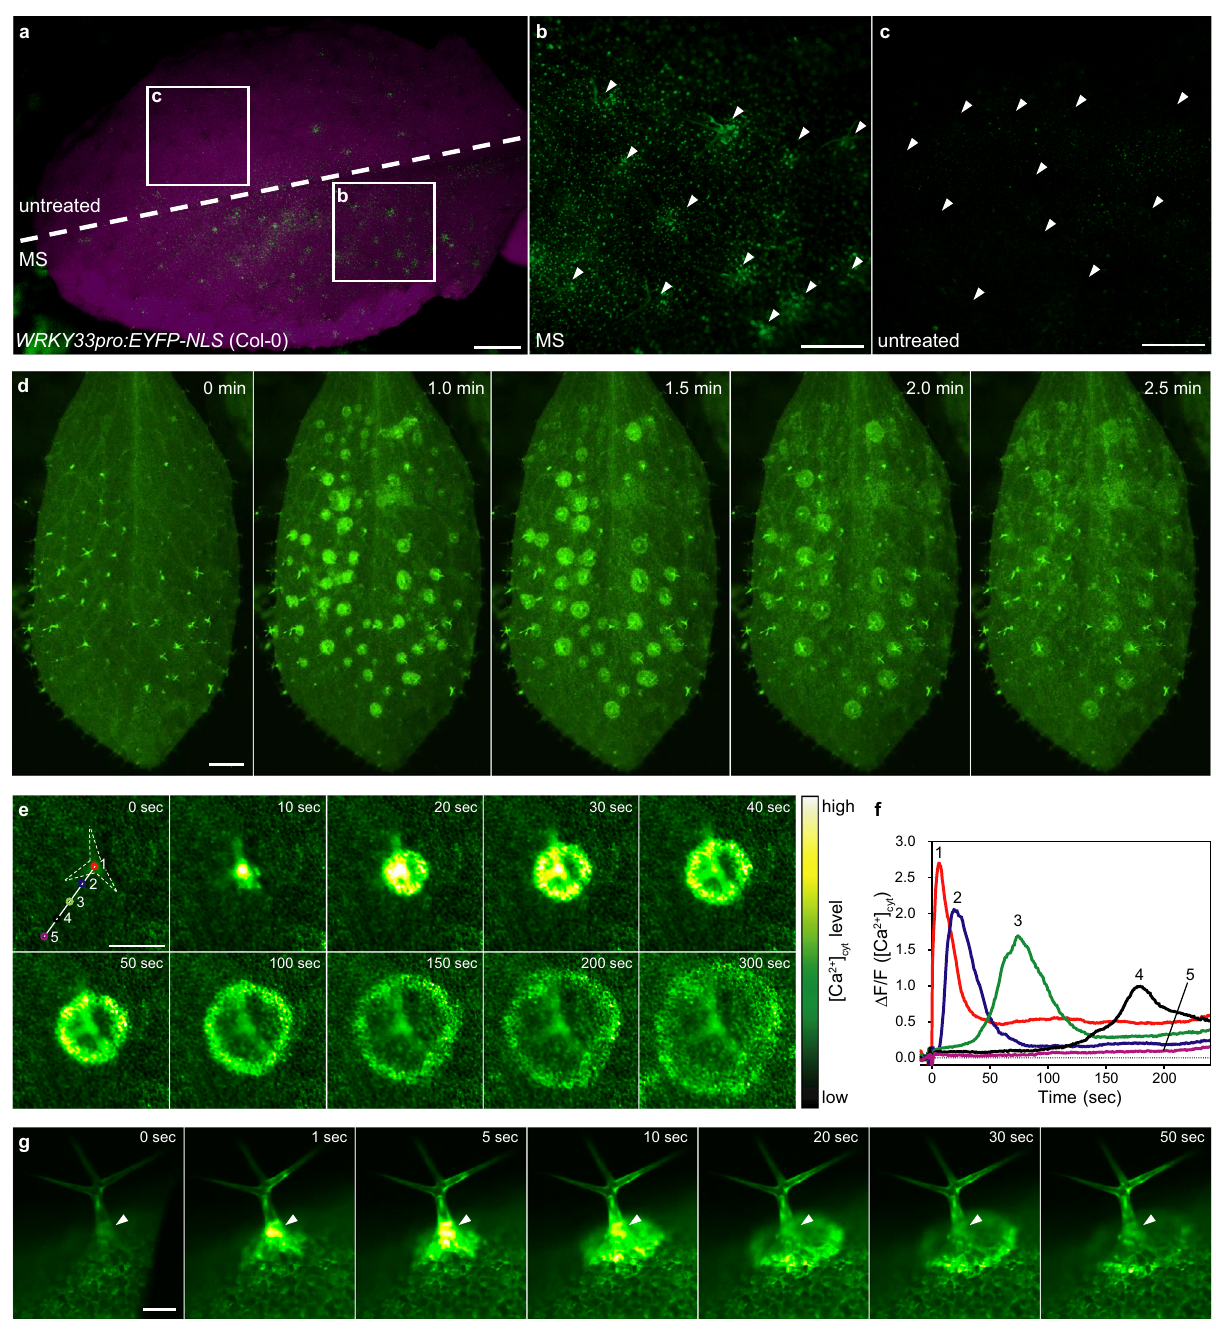
Fig. 4 Trichomes initiate intercellular calcium waves. a – c YFP fl uorescence in a whole leaf from WRKY33pro:EYFP-NLS (Col-0) with (MS, bottom half) or without brushing (untreated, top half) ( a ), along with zoomed-in views of brushed ( b ), and untreated ( c ) areas. Arrowheads indicate trichomes ( b , c ). Scale bars, 0.5 mm ( a ), 0.3 mm ( b , c ). Similar results were obtained in three independent experiments. d Ca 2 + imaging using 35Spro:GCaMP3 (Col-0). The leaf surface of a 4-week-old plant was treated with MS by brushing. MS-induced intercellular calcium waves propagated concentrically from trichomes. Scale bar, 1.0 mm. See also Supplementary Movie 1. e Ca 2 + imaging using 35Spro:GCaMP3 (Col-0). A single trichome from a 2-week-old seedling was fl icked with a silver chloride wire. MS-induced intercellular calcium waves propagated concentrically from the trichome (dashed outline). Scale bar, 0.2 mm. See also Supplementary Movie 2. Similar results were obtained in three independent experiments. f [Ca 2 + ] cyt changes at sites indicated by numbers in ( e ). Similar results were obtained in three independent experiments. g Side view of a trichome whose neck was fl icked with a silver chloride wire. MS-induced intercellular Ca 2 + in fl ux was transiently observed in the trichome base (arrowheads) followed by the formation of circular waves. Scale bar, 0.1 mm. See also Supplementary Movie 3. Similar results were obtained in three independent